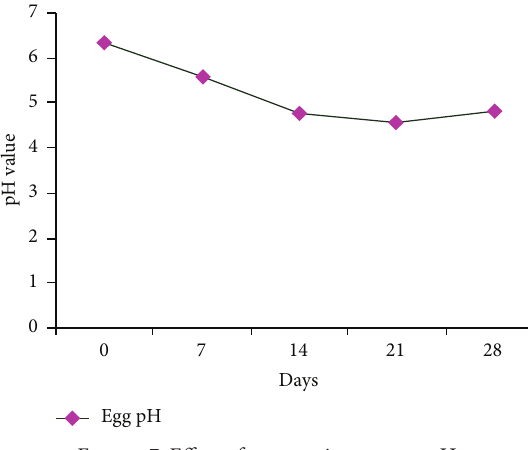
Figure 7: Effect of storage time on egg